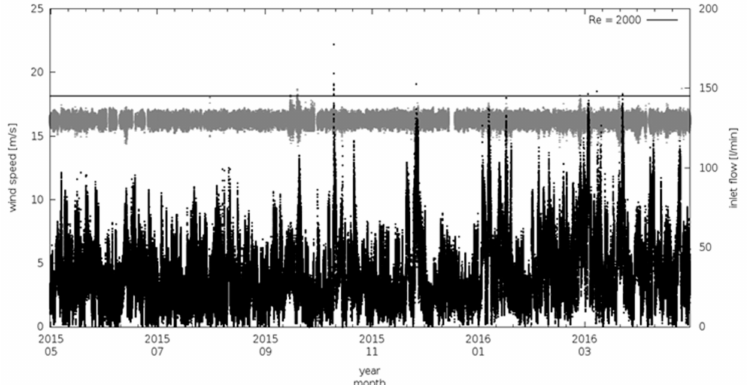
Figure 6. Time series of sampling flow of trace gas intake (grey) and wind speed (back) at CGR (1-min averages). The top black straight line represents the minimum allowed flux to maintain the air residence time below 2 s in the air intake.